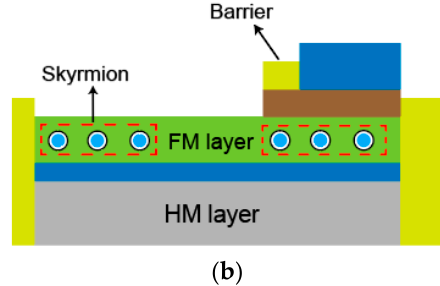
Figure 3. Analogy between the biological synapse ( a ) for the ion transmission and ( b ) the corresponding schematic of the skyrmion-motion-induced resistive change device structure [28].